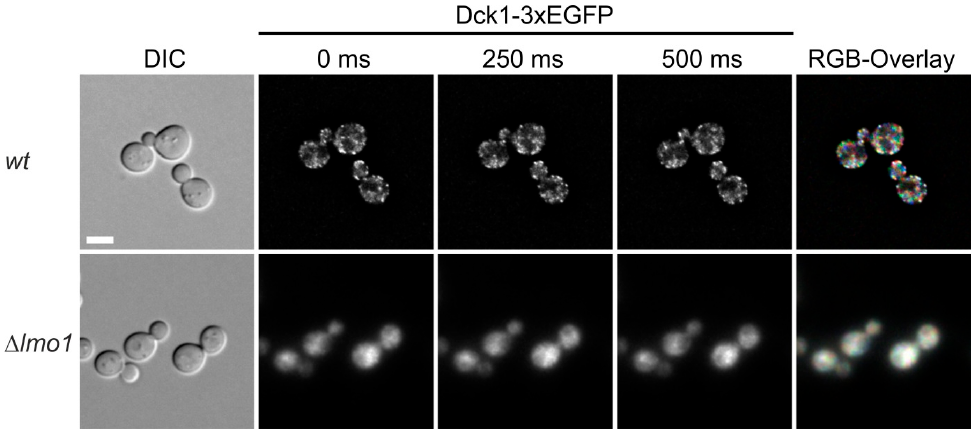
Figure 2. Dck1 forms transient foci. Images of individual cells forming foci were taken and color coded in the RGB overlay from different time-points to visualize movement (see also movie in supplementary materials). The diffuse distribution in the lmo1 deletion was used as a control. The scale bar in the upper left image represents 5 µm and is valid for all images. See Materials and Methods for further details.